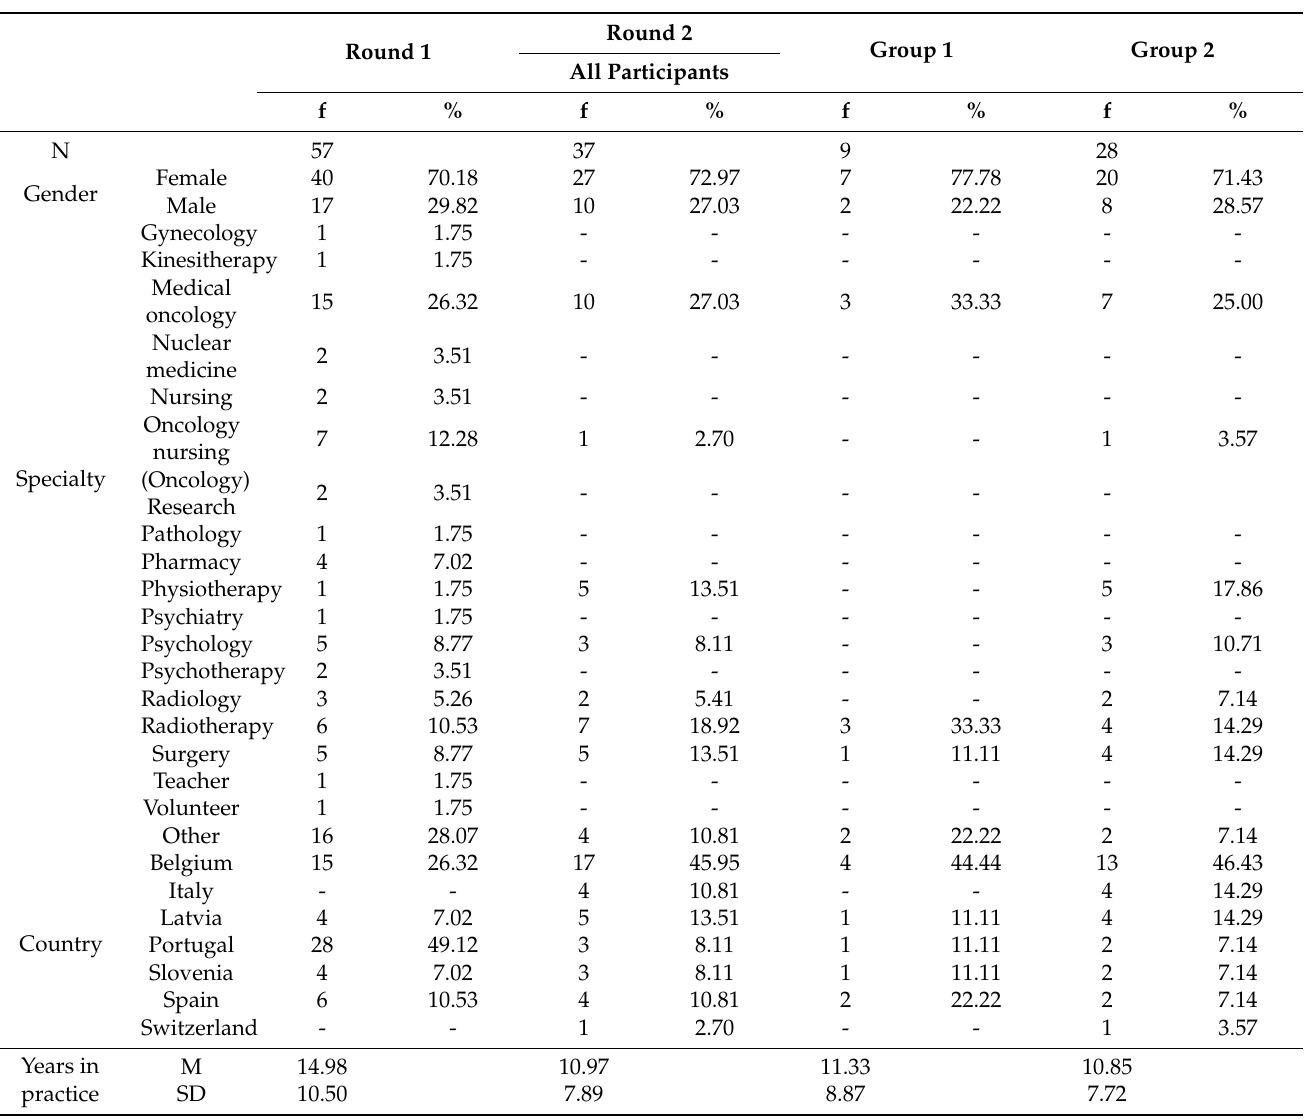
Table 1. Participants’ characteristics. Group 1: Participants included in both rounds. Group 2: Participants included only in the 2nd